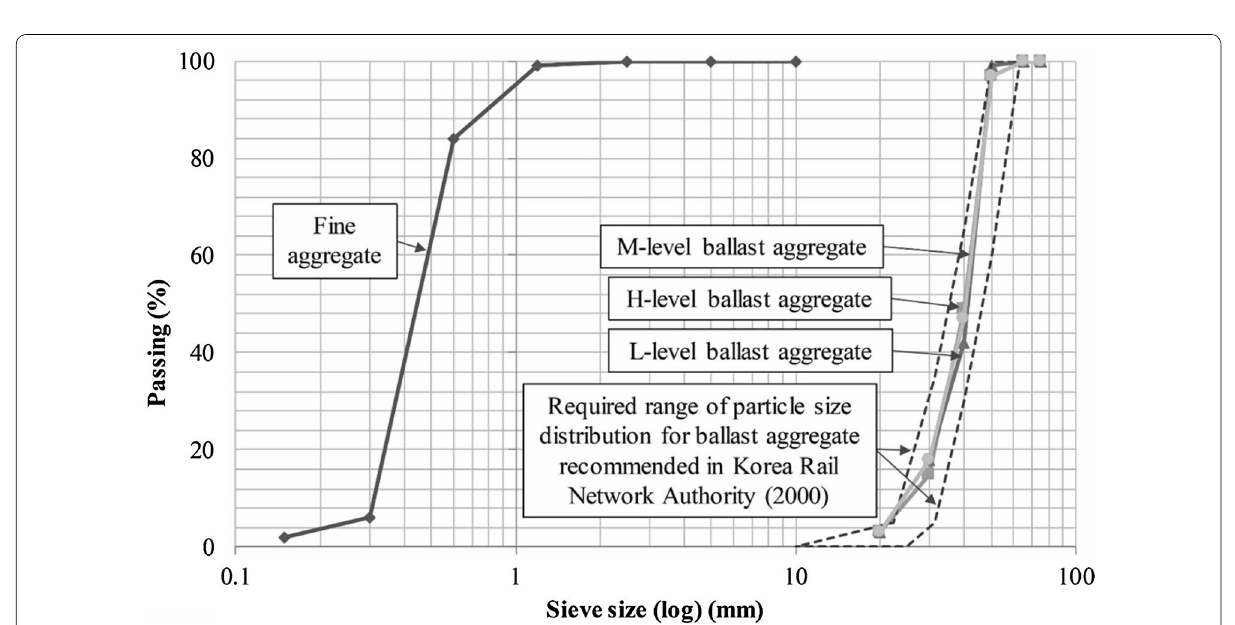
Fig. 8 Particle size distributions of fine and ballast aggregates.